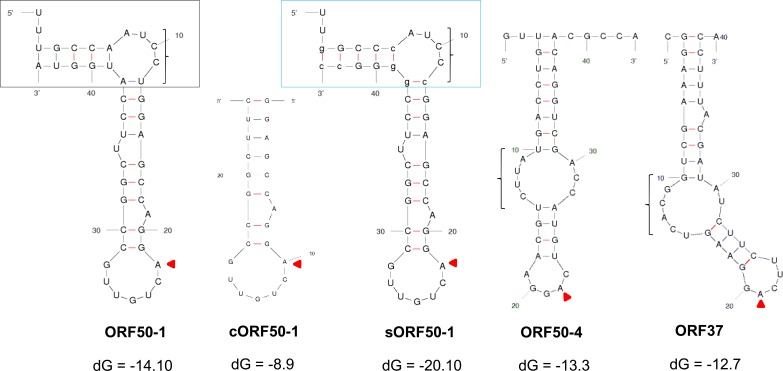
RNA secondary structure prediction of viral RNA baits.Free energy RNA structures for viral RNA baits as predicted by UNAfold web server. Note that the beginning of the stem of ORF50-1 bait (black box) presents weak base-pairing with four unpaired nucleotides (AUCC). The stable ORF50-1 bait (sORF50-1) has seven nucleotides replaced compared with ORF50-1 (mutated bases are indicated in lower case) to stabilise this region (blue box). Triangles point to the adenosine that is m6A-modified at the GGACU motif within the apical loop. Curly braces highlight large unpaired bulges. Free energy (dG) is shown for each bait.